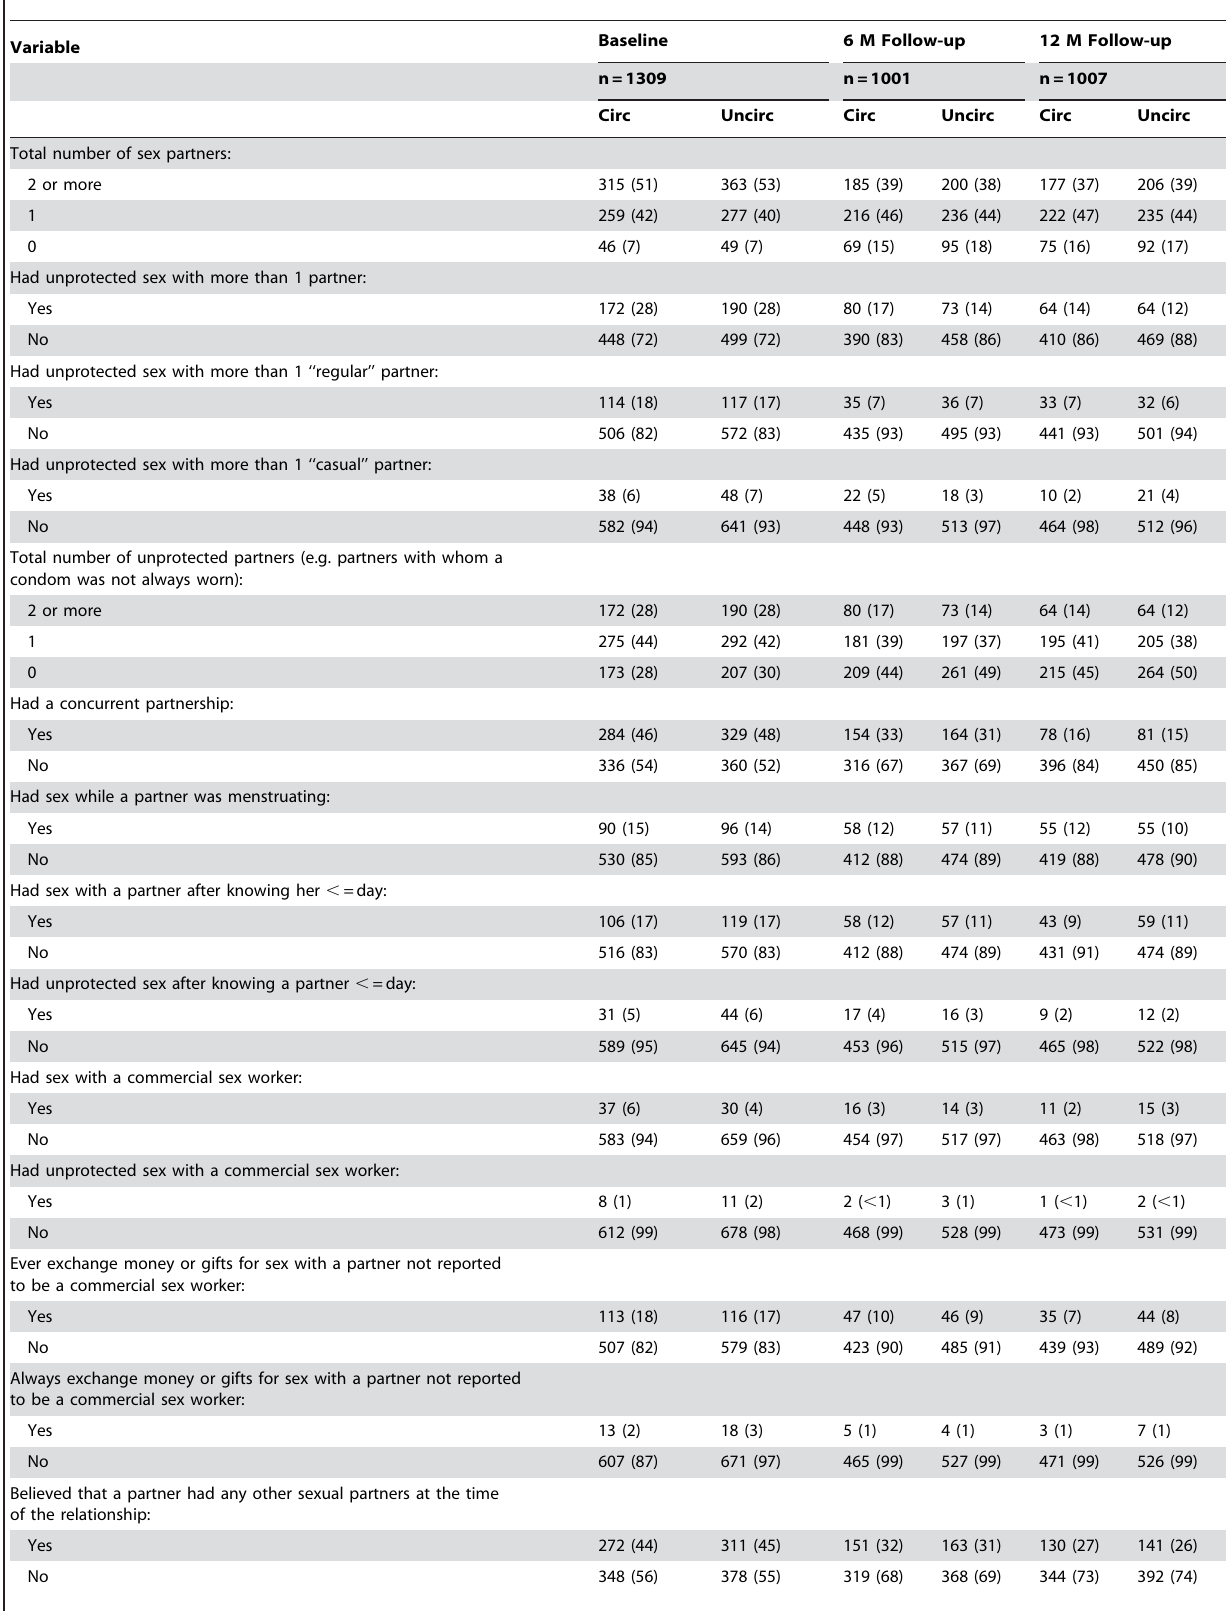
Table 2. Sexual Risk Scale Items for Circumcised and Uncircumcised Men at Baseline, 6 and 12 Month Follow-up Visits*